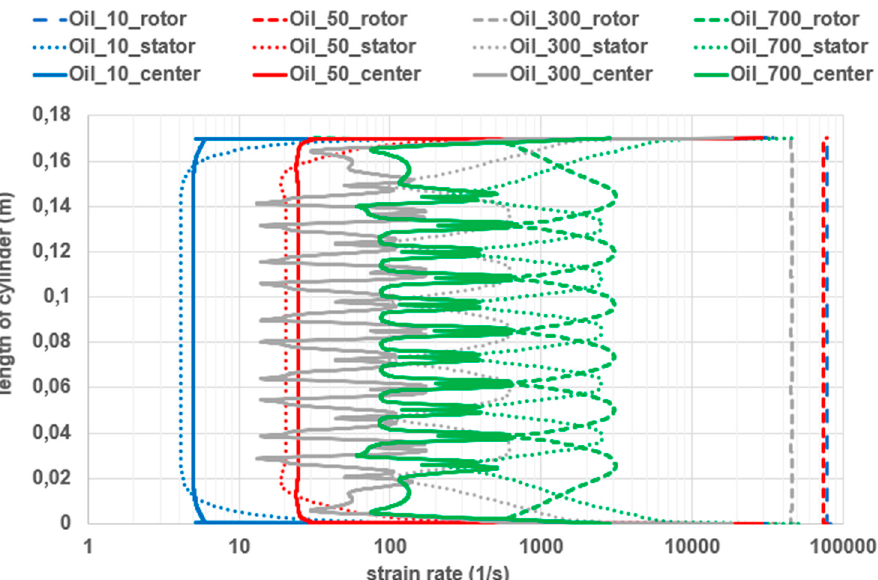
Figure 10. Dependence of the strain rate in logarithmic coordinates on the length of the cylinder for oil on the rotor, stator and in the middle of the gap.